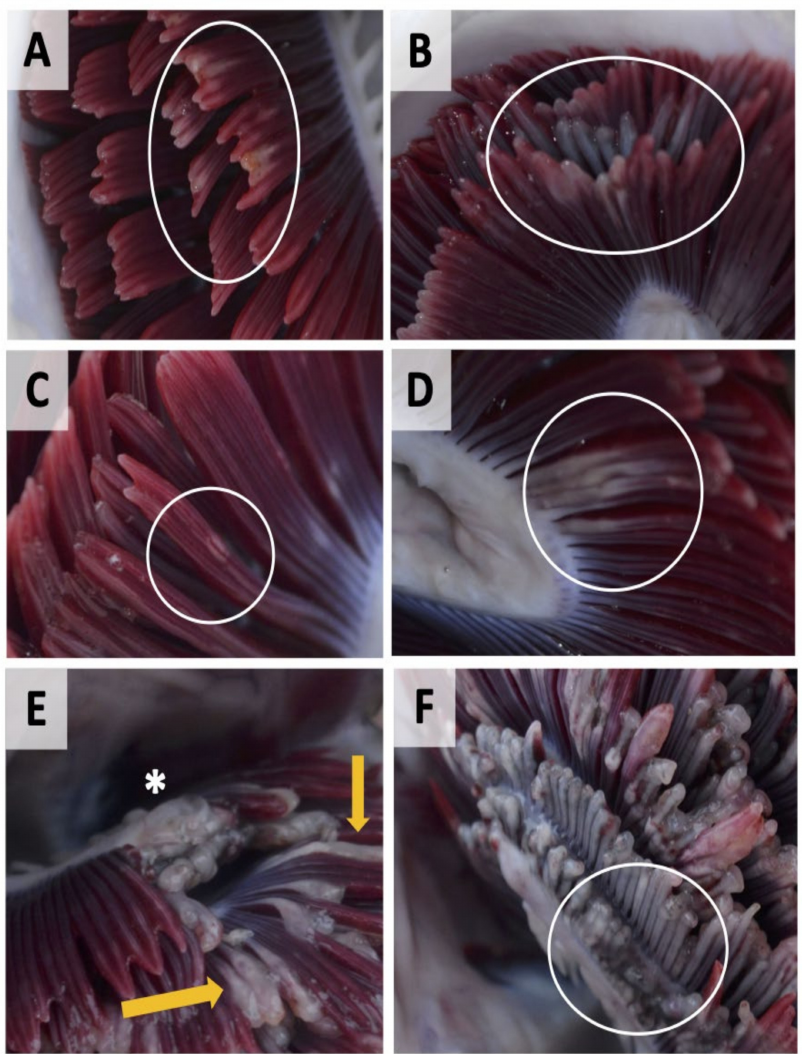
Figure 1. Examples of gross gill pathologies in farmed Atlantic salmon in Cupquelan Fjord displaying multifactorial gill disease. ( A ) superficial shortening of gill filaments with varying degrees of gill pallor and mucus accumulation (white circle); ( B ) more extensive erosion of filaments (white circle); ( C ) presence of discrete focal spots or streaks on the gill filaments (white circle); ( D ) multi-filamental patch with mucus accumulation (white circle); ( E ) grossly thickened/swollen gill filaments (yellow arrows), area of total filament erosion and necrotic patches (asterisk); ( F ) extensive filament erosion, pallor and areas of melanisation (white